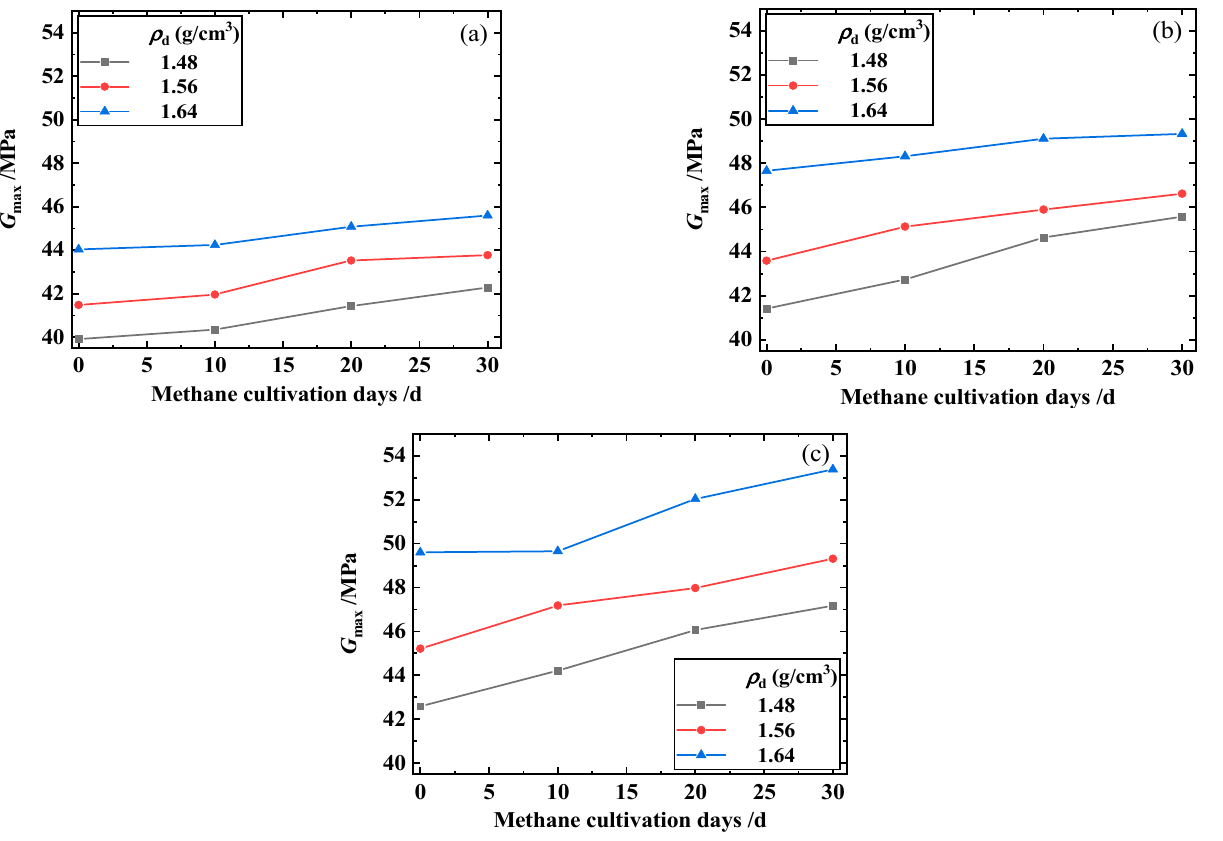
Figure 11. Relationship between G max and methane cultivation days of the biochar–methanotroph– clay mixture, under different biochar contents: ( a ) α = 0%; ( b ) α = 10%; ( c ) α = 15%.